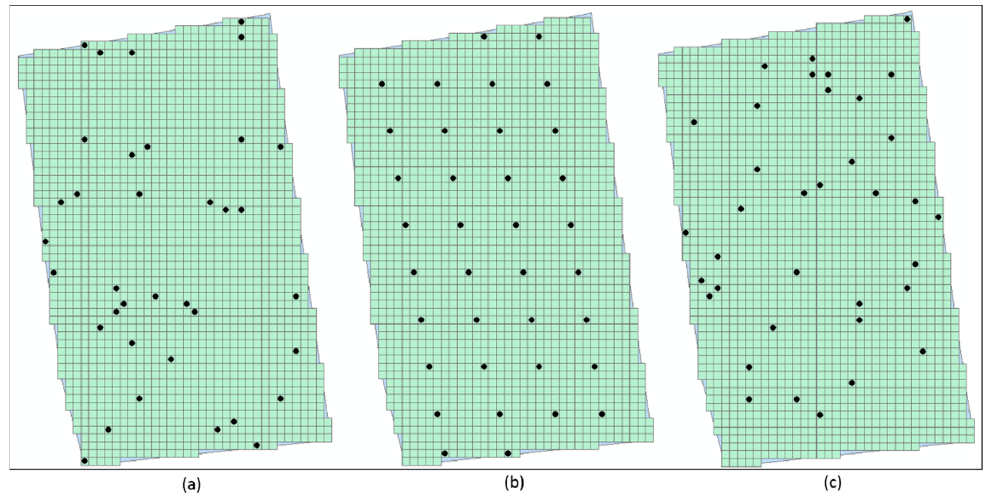
Figure 6. The comparative results of the three sampling design methods: ( a ) The proposed method with the optimal super-grid size, ( b ) regular grid sampling, and ( c ) k-means sampling. Table 4. The descriptive statistics of the SOM contents of the farm field soil samples that were produced by the three sampling design methods.